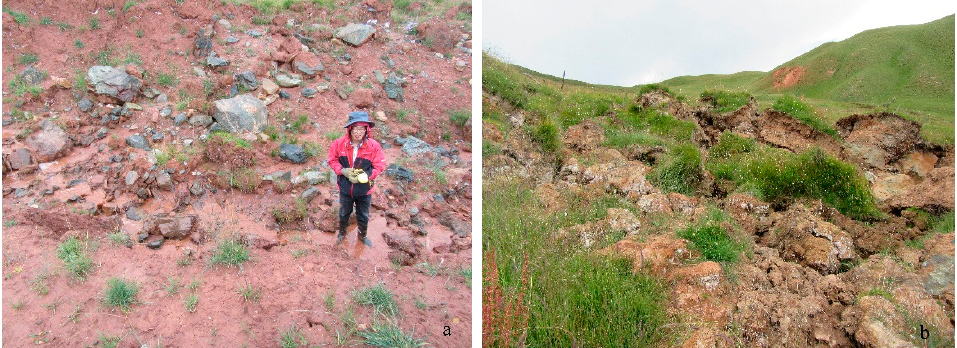
Figure 2. Photos taken at the field work. ( a ) Field work about the drainage network survey on July 06, 2015, and ( b ) the ragged land surface in the HNG catchment.